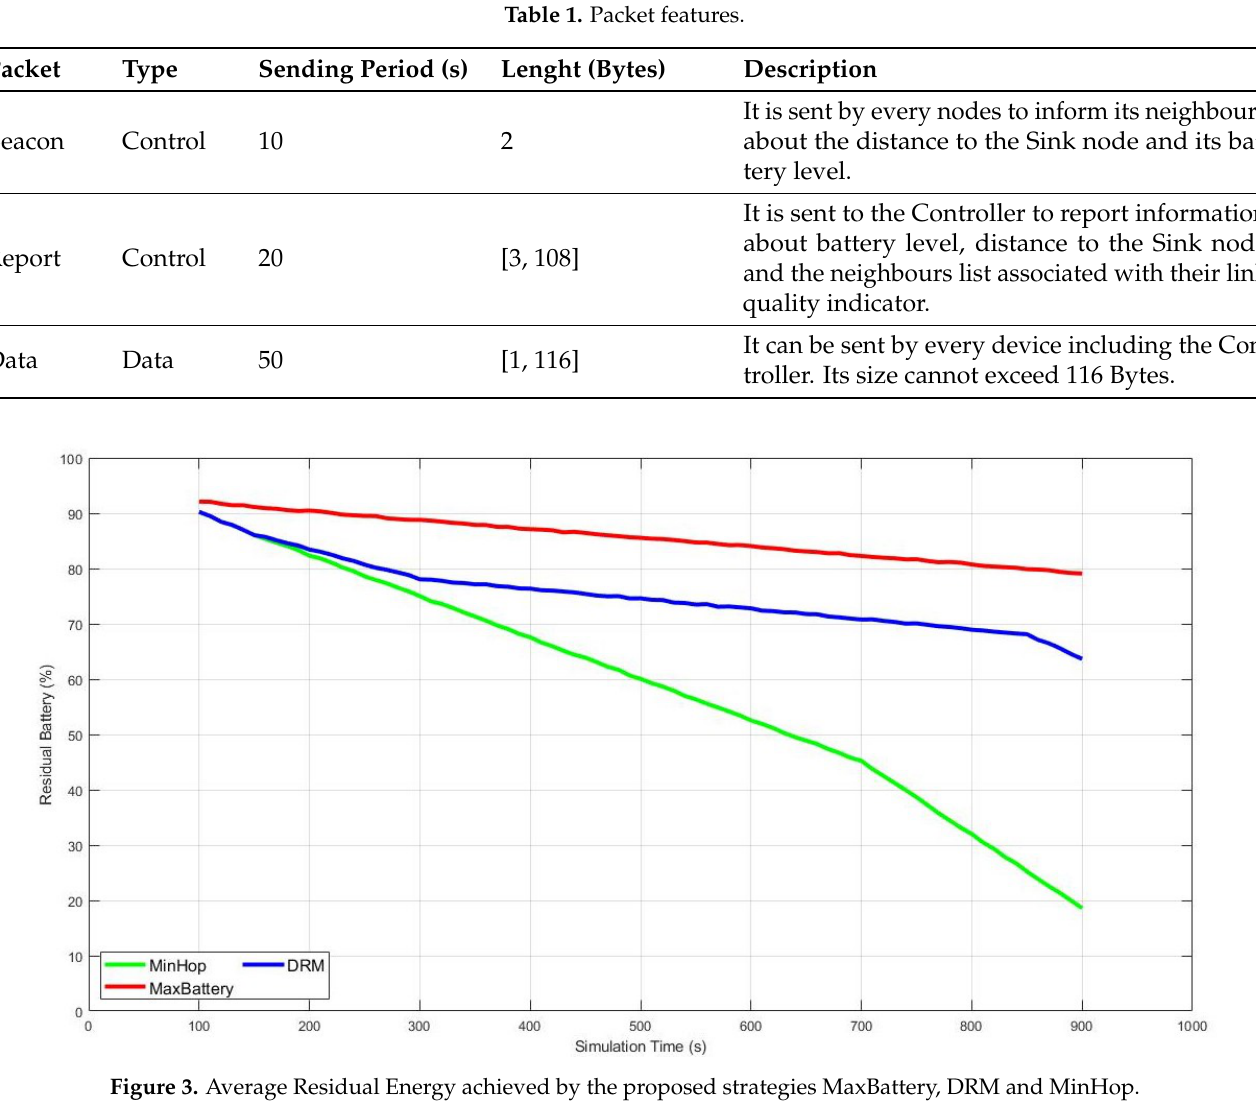
Figure 3. Average Residual Energy achieved by the proposed strategies MaxBattery, DRM and